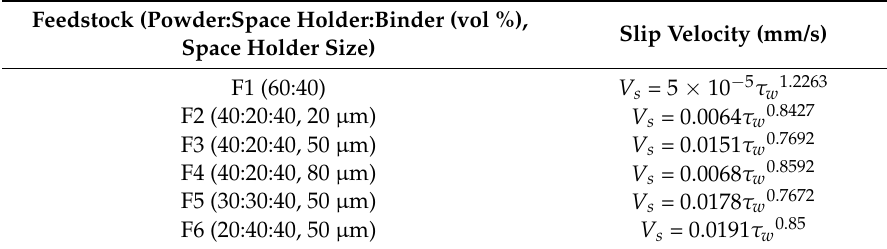
Table 6. Slip velocity as a function of a power law for each feedstock.